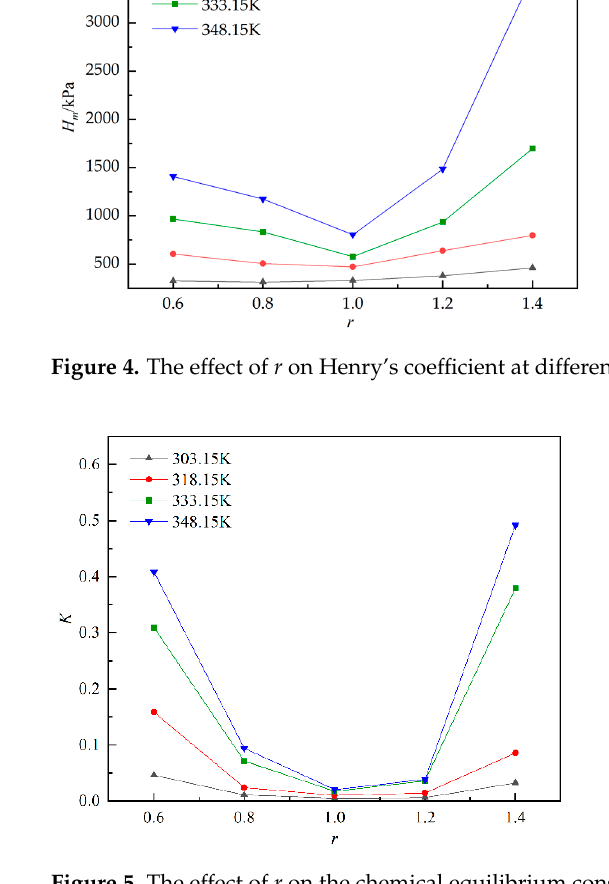
Figure 5. The effect of r on the chemical equilibrium constant at different temperatures.